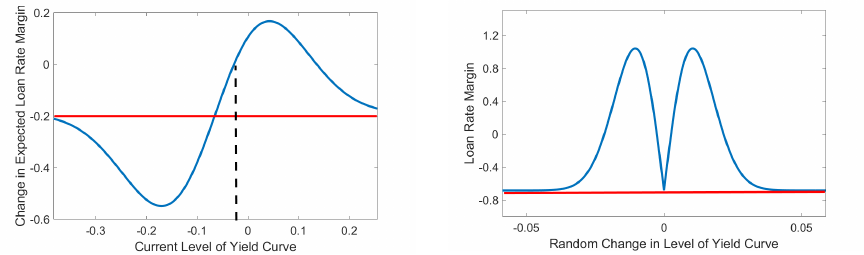
Figure 6. Loan Rate Margin (61) (LHG) and (64)